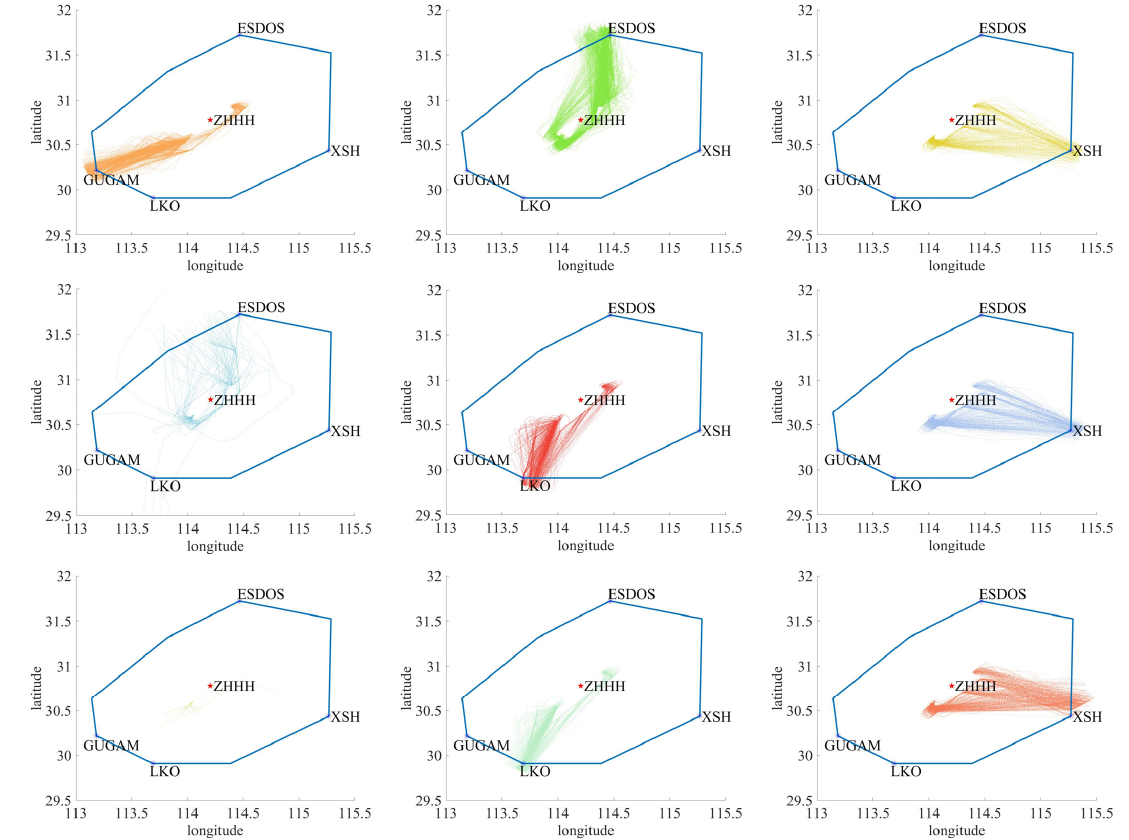
Figure 11. Clustering results of flight trajectories of ZHHH (K-Means).